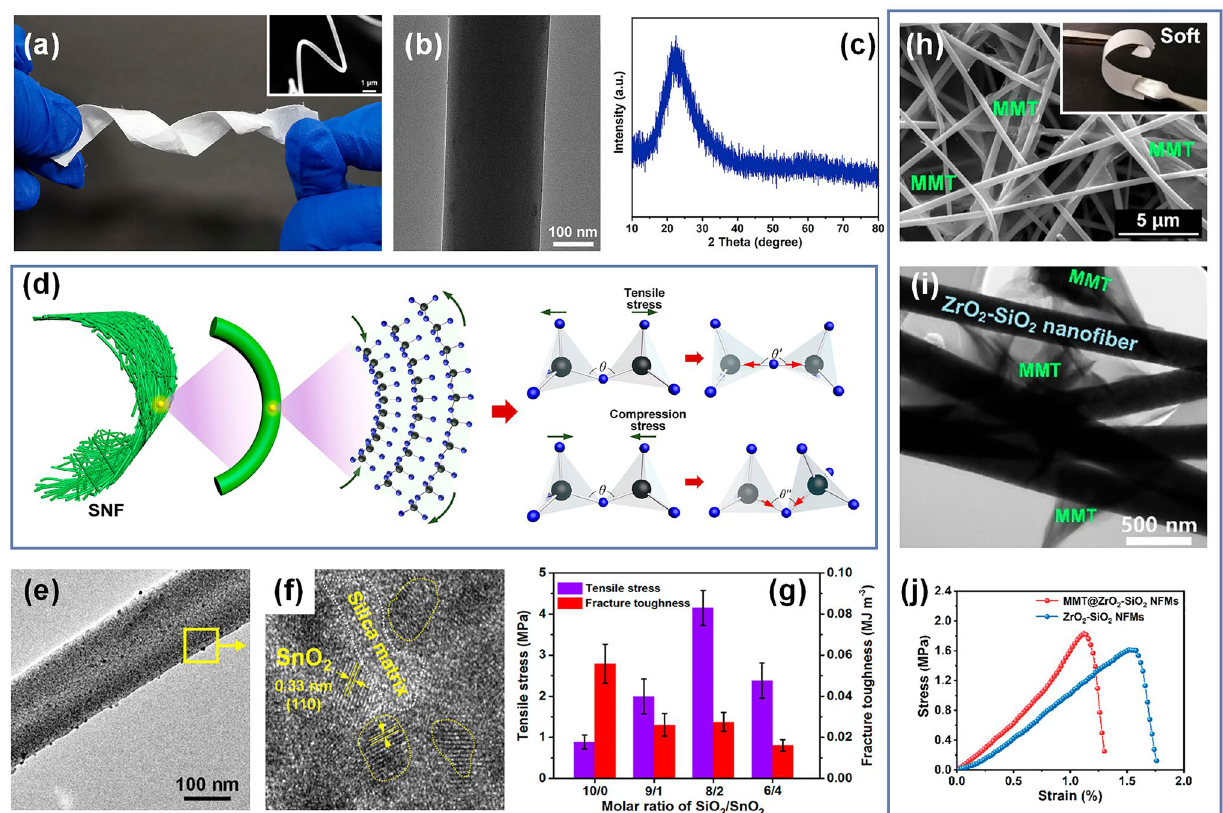
Fig. 8 a Optical photograph of a flexible SNFs membrane. The inset is the SEM image of the corresponding flexible single nanofiber [147]. b TEM image of the SNFs [147]. c XRD spectrum for the SNFs [147]. d Plausible mechanism for the flexibility of SNFs [147]. Copyright 2022, American Chemical Society. e TEM image of the SiO 2 /SnO 2 nanofiber [161]. f High‑resolution TEM image of a selected area [161]. g Tensile strength and fracture toughness of